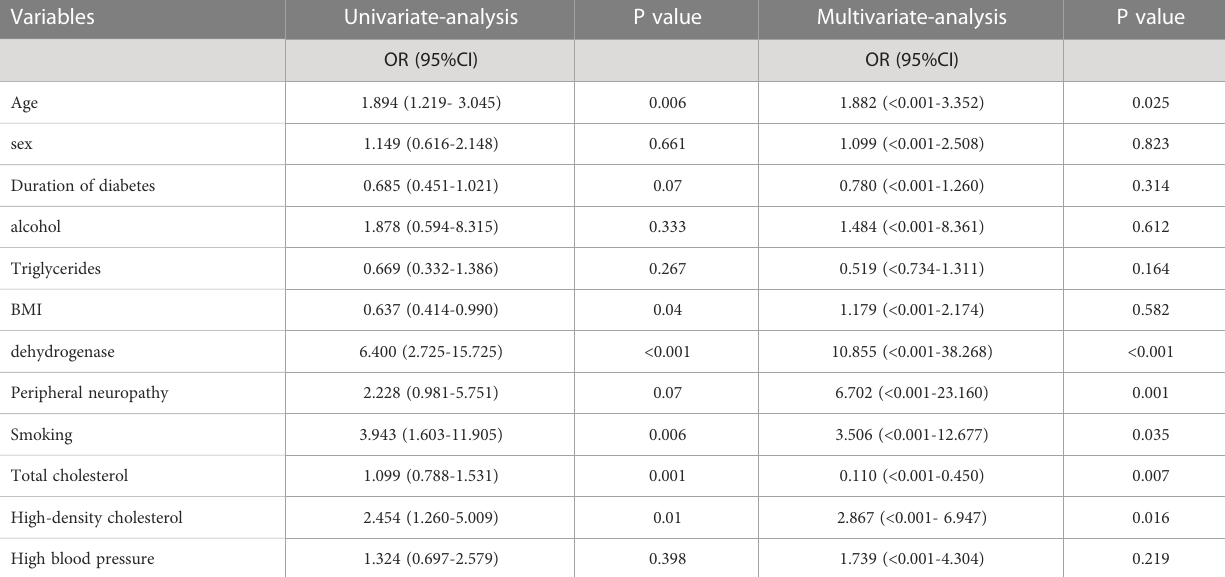
TABLE 2 Logistics regression univariate and multifactor analysis.